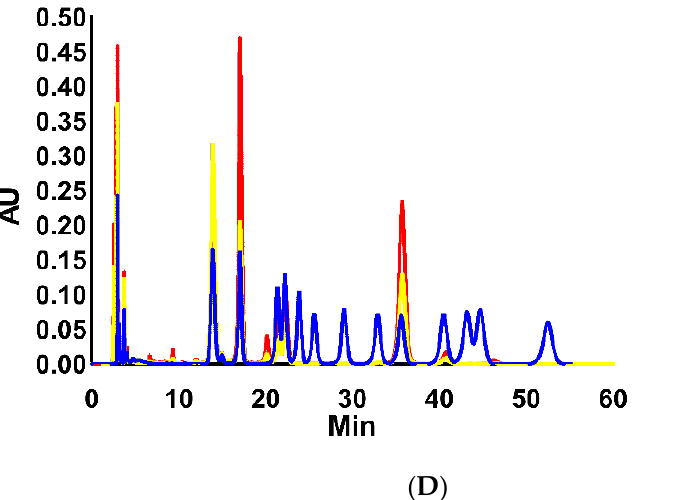
Figure 3. Monosaccharide composition analysis by HPLC. ( A ) peak spectrum for standards, ( B ) peak spectrum for EPS, ( C ) peak spectrum for SeEPS and ( D ) comparison among EPS, SeEPS and standards.